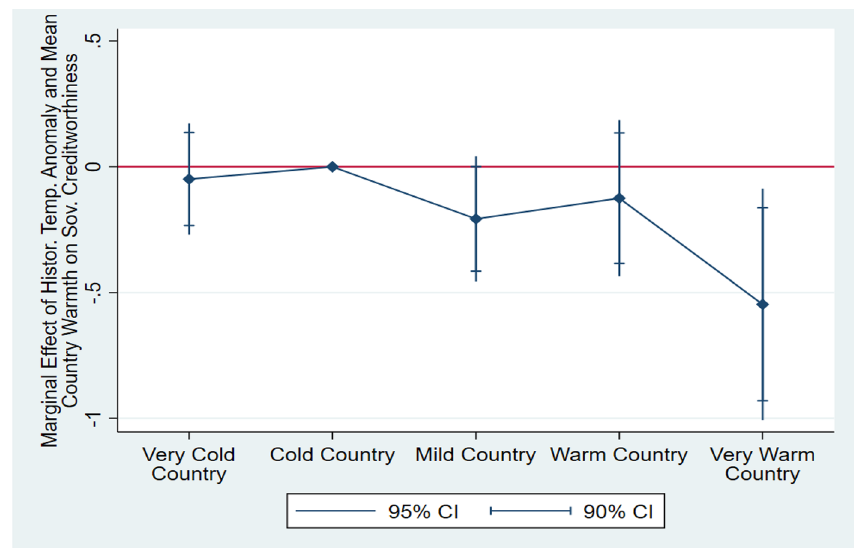
Fig. 5 Coefficients estimated in Table 7 for climatic bins according to 5 ◦ C intervals of average temperature